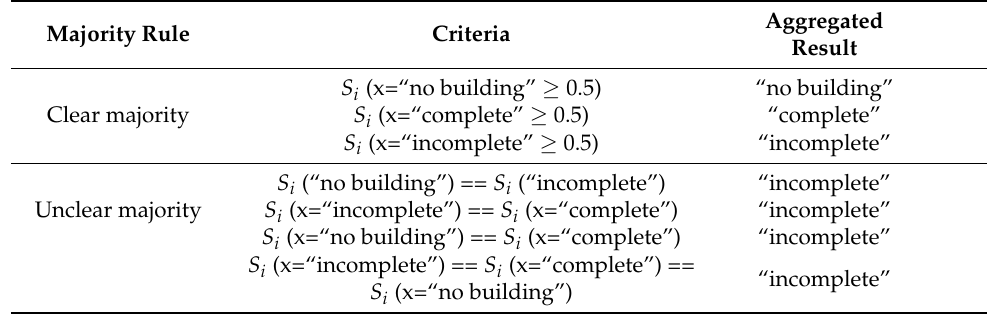
Table 2. Classification aggregation schema. S i (x = “no building”) describes the share of users that assigned the label “no building” to task i . S i (x = “incomplete”) and S i (x = “complete”) describe similar the share of users that assigned the label incomplete or complete to task i